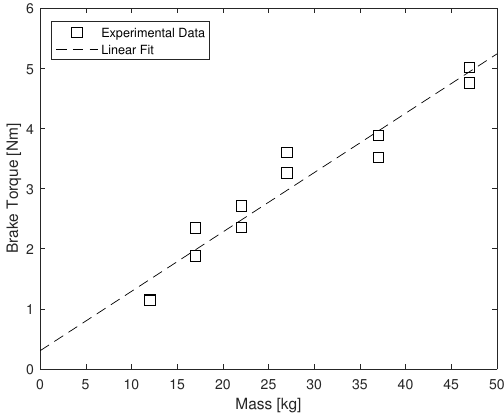
Figure 6. Dynamic braking